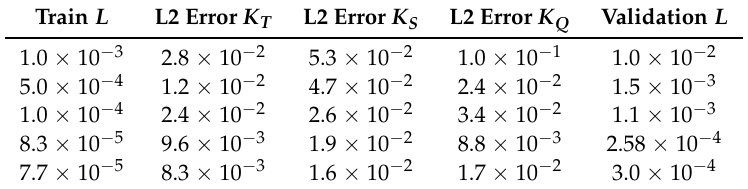
Table 3. L2 norm error for different tolerances of L for validation of neural network for behind condition forces.